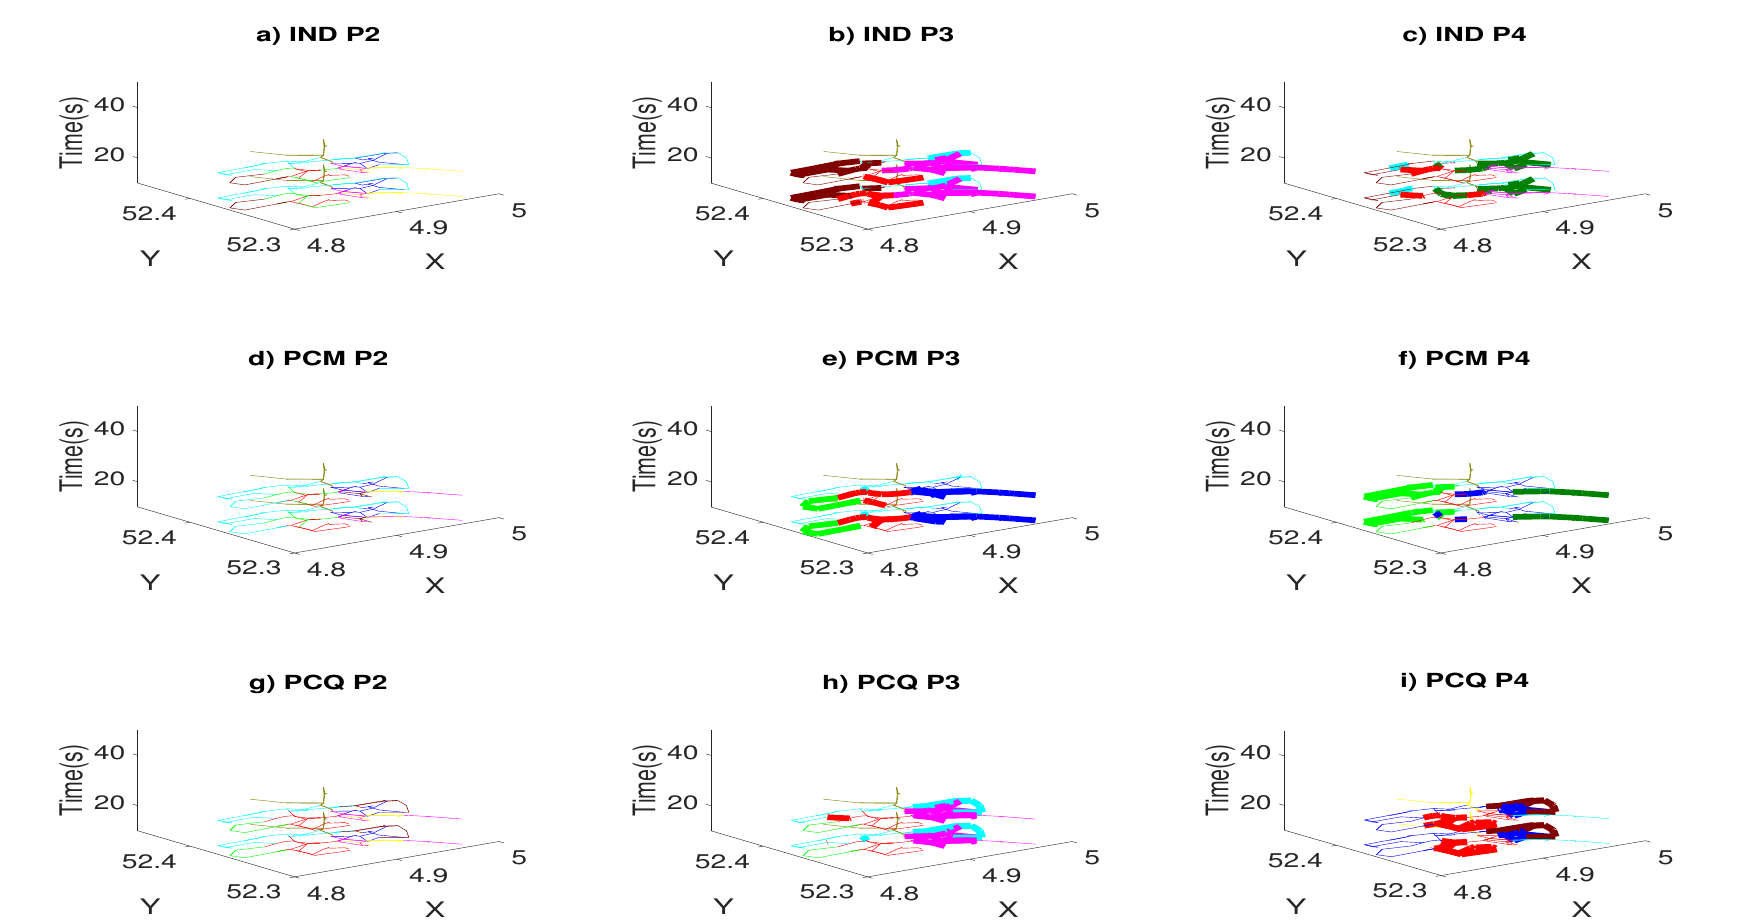
Figure 23. Clustering results for time periods from t = 2 to t = 4 for the IND, PCM and PCQ methods in the case of time period = 20